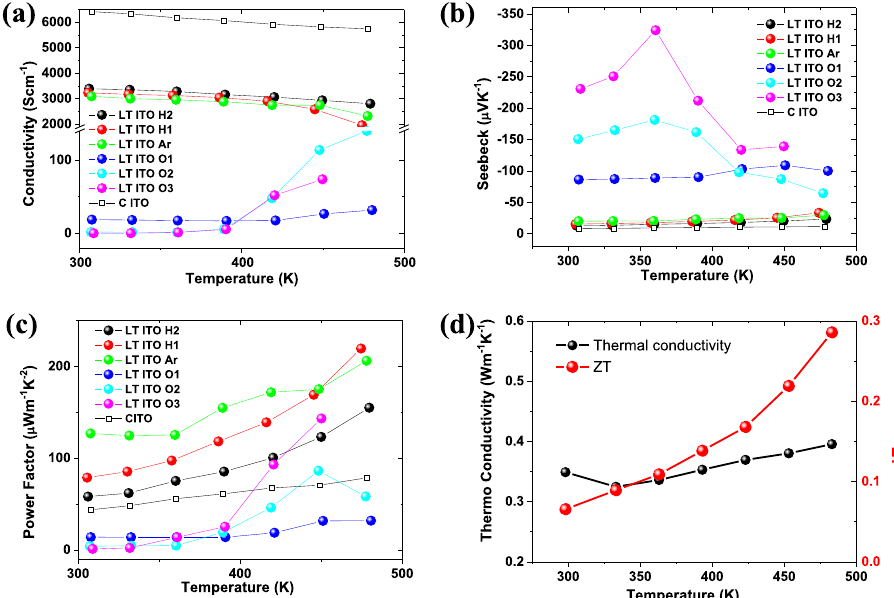
Fig. 3 Thermoelectric properties of ITO fi lms deposited under a pure argon environment, or at different hydrogen or oxygen partial pressures. a Electrical conductivity, b Seebeck coef fi cient, and c power factor (PF), as a function of temperature. d The thermal conductivity (TC) and fi gure-of-merit zT of the ITO thin fi lm sample Ar, as a function of